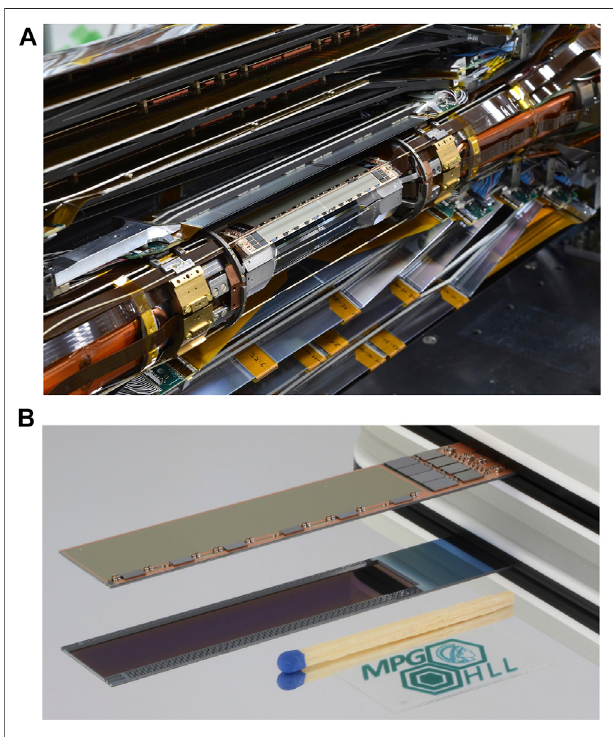
FIGURE 2 | (A) shows a picture of a half shell of the vertex detector of Belle II. The innermost layers are the two DePFET based PXD sensors. One Module of the PXD sensor modules is shown in (B) . Within the sensitive area, the sensor is thinned to 75 μ m, readout and control ASICs as well as passive components are mounted on the balcony of the all silicon module (Pictures curtesy of the Belle II